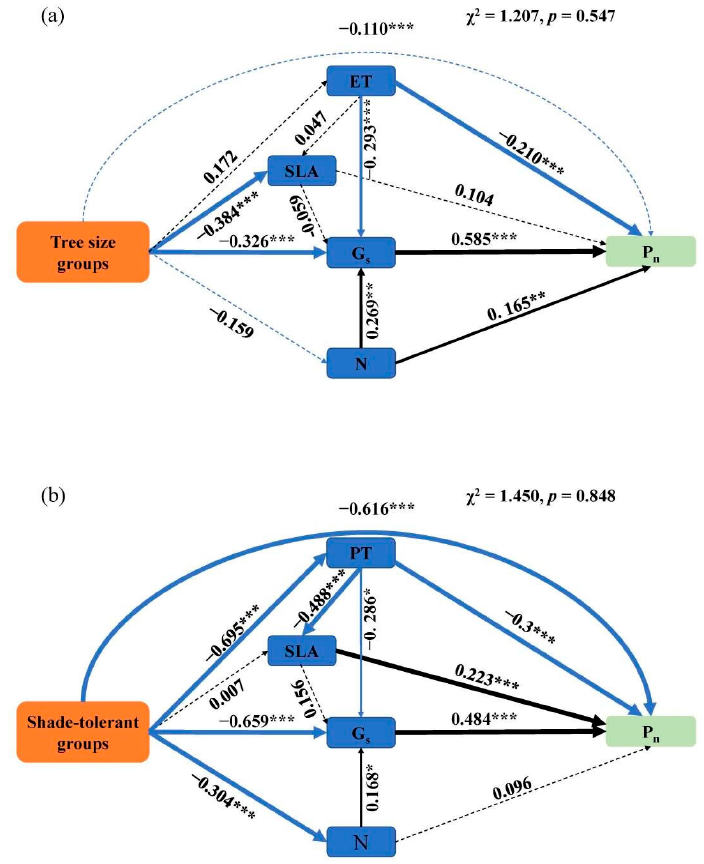
Figure 3. Structural equation model of tree type influencing P n . The solid lines indicate significant paths, and the thickness of the solid line represents the degree of significant correlation (*, p < 0.05; **, p < 0.01; ***, p < 0.001.), while the dotted lines indicate nonsignificant paths ( p > 0.05). The meanings of abbreviations are shown in Table 2. ( a ) Structural equation model of tree sizes influencing P n ; ( b ) Structural equation model of shade tolerances influencing P n.